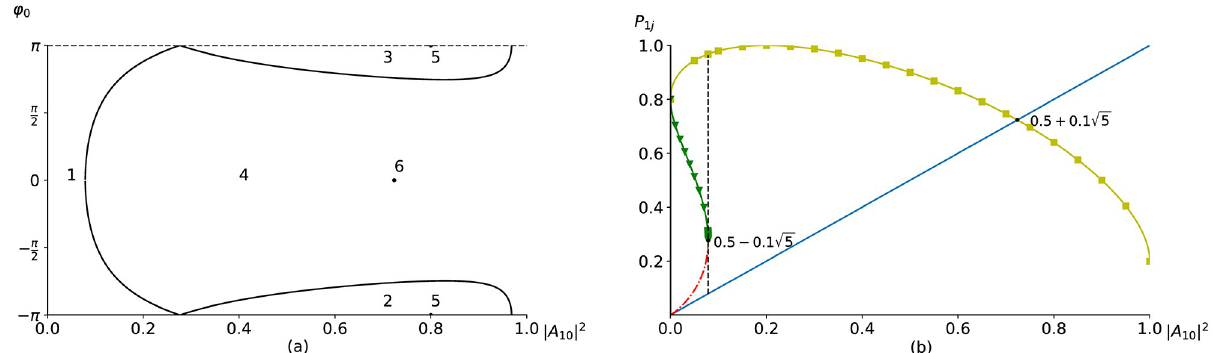
Fig 1. Areas of different number of the problem solution (a): areas 1, 2, 3—four real roots, 4—two real roots and two complex roots, points 5 (0.8, ± π ) —two multiple real roots, 6 ð 0 : 5 þ 0 : 1 zero-value phase difference φ 0 = 0 (b): P